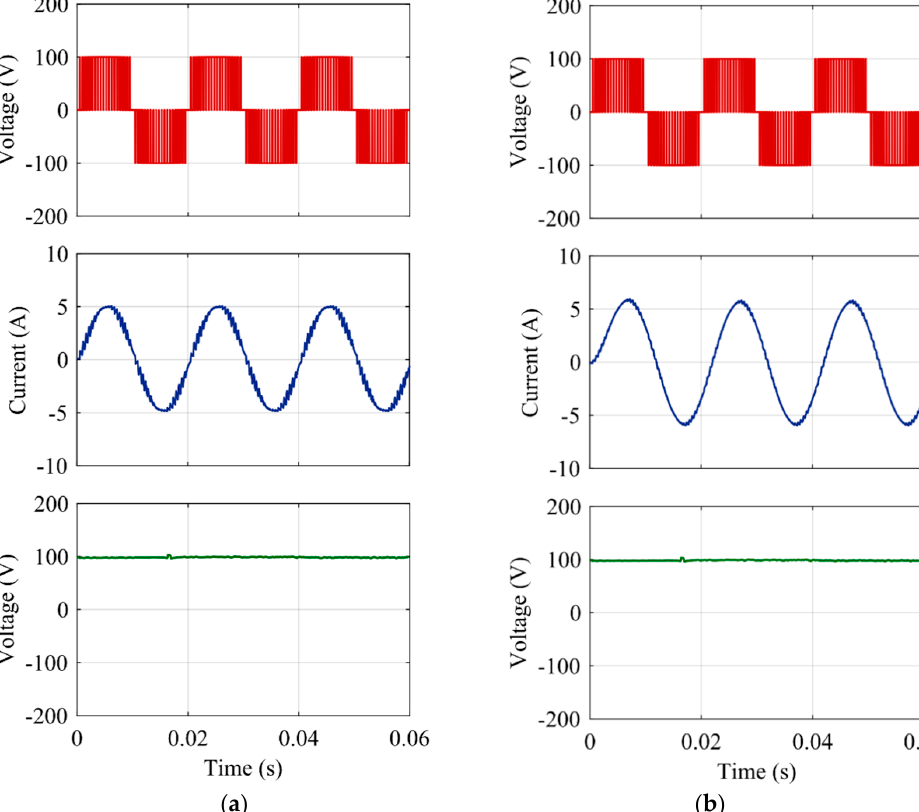
Figure 15. Simulation results for the hybrid ANPC inverter for the output voltage ( V an ), current ( I an ) and common-mode voltage (CMV) with ( a ) unity power factor, ( b ) non-unity power factor.